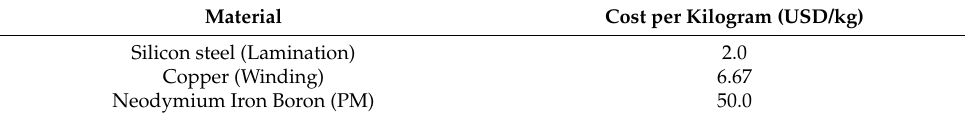
Table 5. Approximate costs of different materials for PMSM components [40].